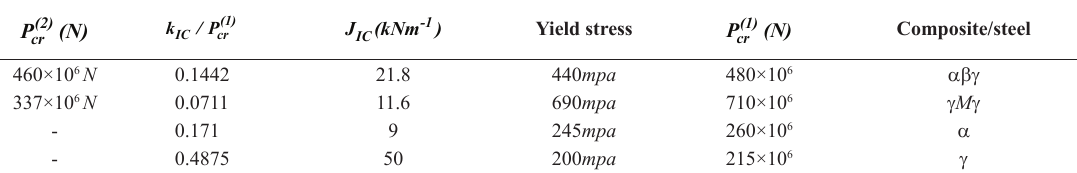
Table 1. Mechanical properties and critical normal loads for